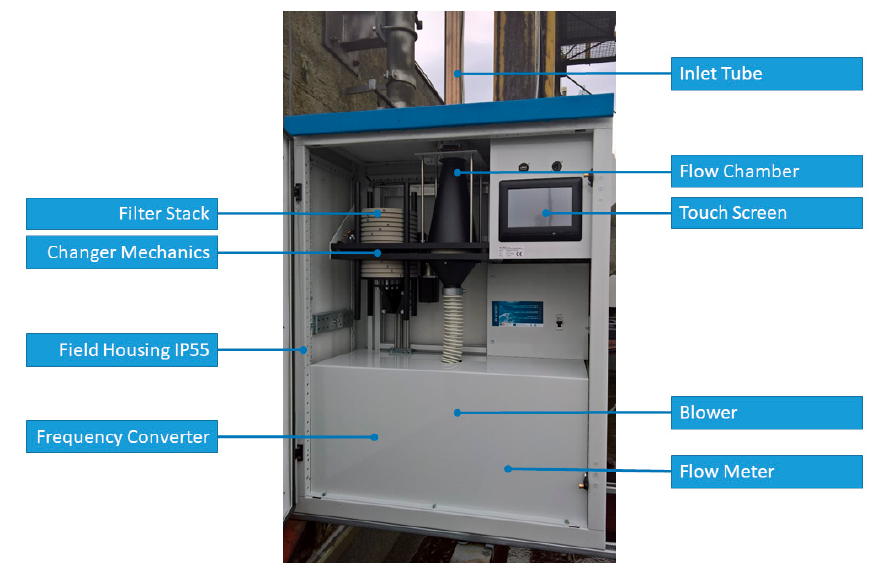
Figure 3. The SAM Hi 30 AUTO WIND sampler.